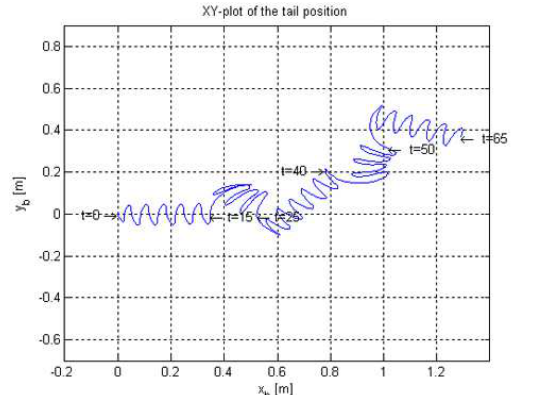
Figure 9: XY-plot of the tail position of the snake in the base-frame for the simulated gait pattern, lateral undulation.